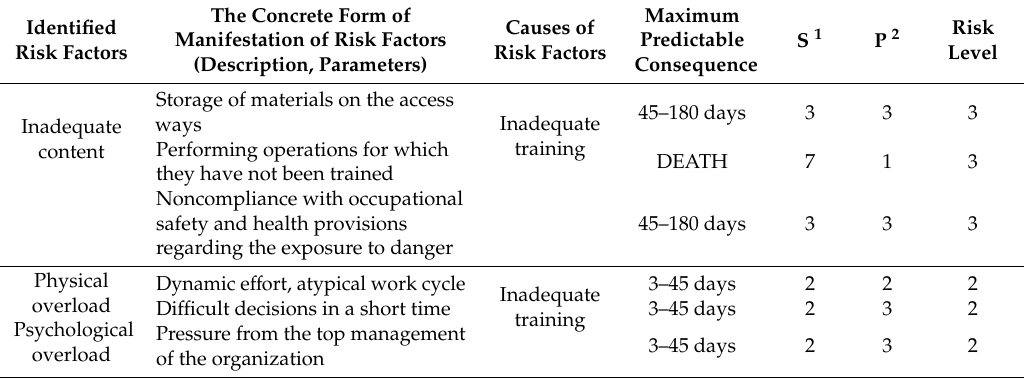
Table 3. Analysis and evaluation of the risks of injury and occupational disease related to the factors of own work load.